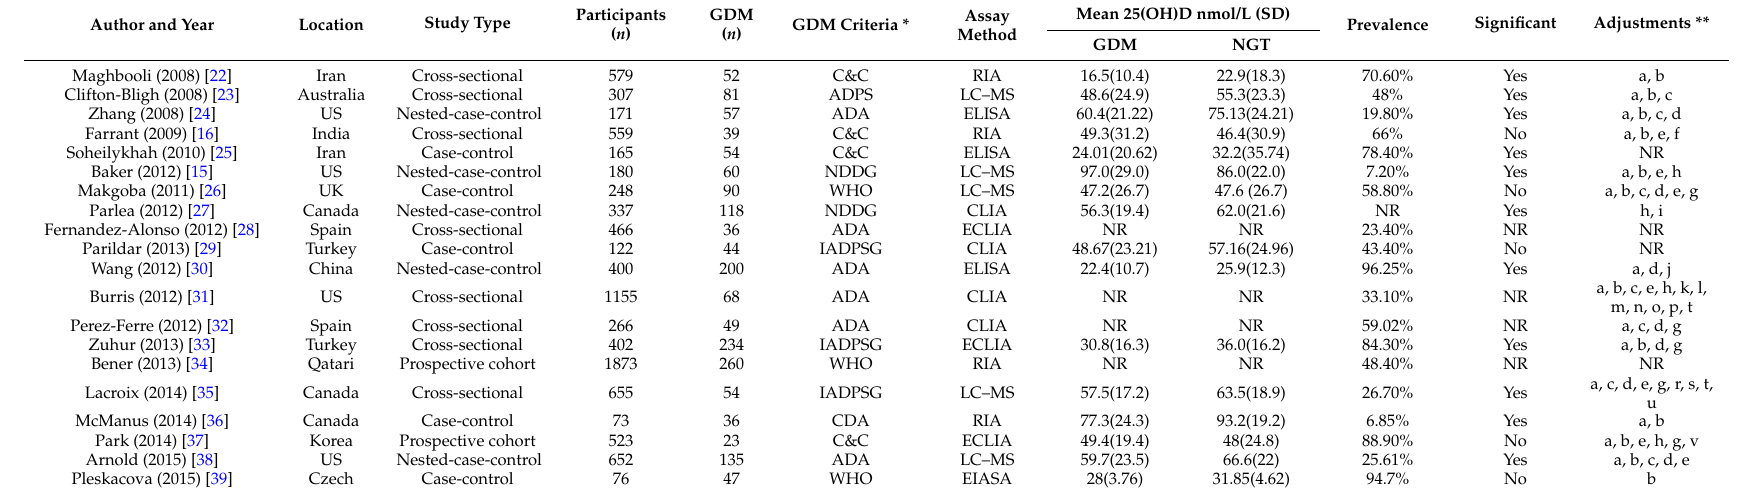
Table 1. Characteristics of observational studies included in this